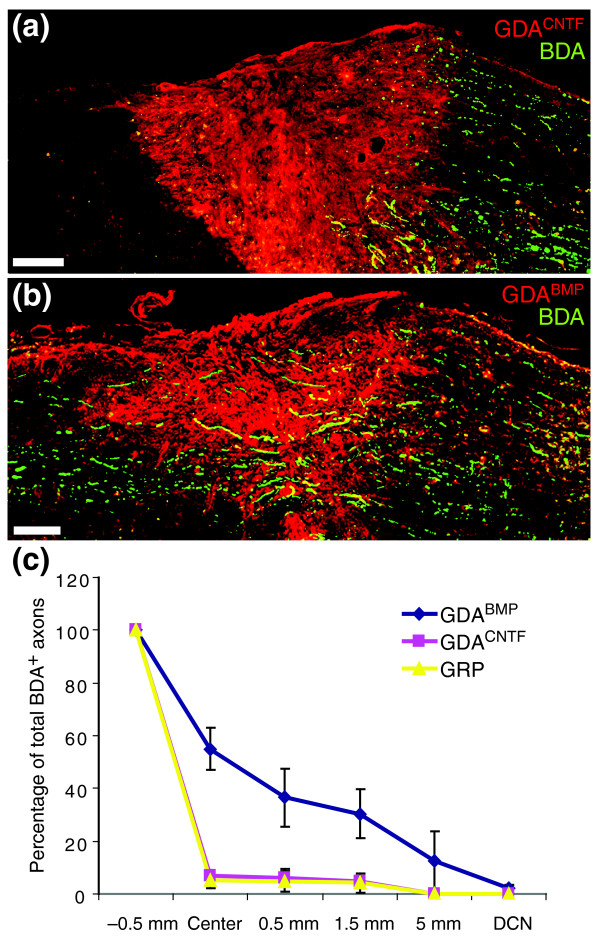
Failure of axons to regenerate across GDACNTF or GRP transplanted dorsal column injuries. (a) Biotinylated dextran amine (BDA)-labeled endogenous, ascending dorsal column axons (green) fail to cross GDACNTF-transplanted injury sites and instead form dystrophic endings within caudal injury margins. While a few axons sprout towards the injury center, BDA+ axons are rarely detected beyond the injury/transplantation site at 8 days post-injury/transplantation. Scale bar 200 μm. (b) In contrast, transplanted GDAsBMP support extensive axon growth across dorsal column injuries at 8 days after injury/transplantation. Scale bar 200 μm. (c) Quantification of numbers of regenerating BDA+ axons in GDA- or GRP-transplanted dorsal column white matter at 8 days after injury and transplantation. BDA-labeled axons were counted in every third sagittally oriented section within the injury center and at points 0.5 mm, 1.5 mm and 5 mm rostral to the injury site and within the dorsal column nuclei (DCN). Note that 55% of BDA+ axons reached the centers of GDABMP-transplanted injuries, and 36% to 0.5 mm beyond the injury site. After GDACNTF or GRP transplantation, however, only 7% and 5.3% of BDA+ axons, respectively, were observed within injury centers, with only 4.6% and 4.2% of the axons observed at 0.5 mm beyond the injury site. No BDA+ axons were detected beyond 1.5 mm rostral to the injury site in GDACNTF- or GRP-transplanted spinal cords. Error bars represent 1 SD.